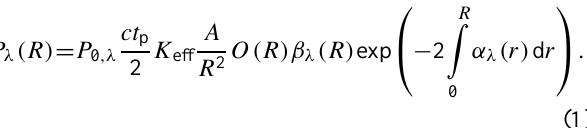
Fig. 1. Scheme of the elastic backscatter lidar of UHOH. APD: Avalanche photodiode, BE: for aerosol and temperature measurements (Behrendt et Beam expander, BSM: Beam steering mirror, DBS: Dichroic beam splitter, IF1 - IF2: Interference filter, L1-L3: Lenses, PMT: Photomultiplier tube, PD: Photodiode.